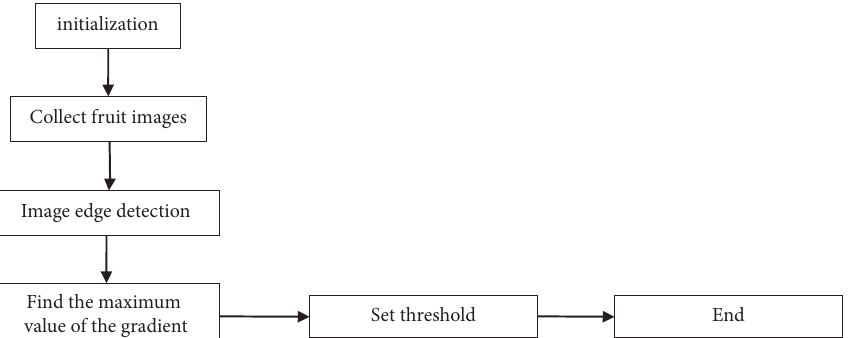
Figure 4: Picking robot edge detection and recognition process of the picking